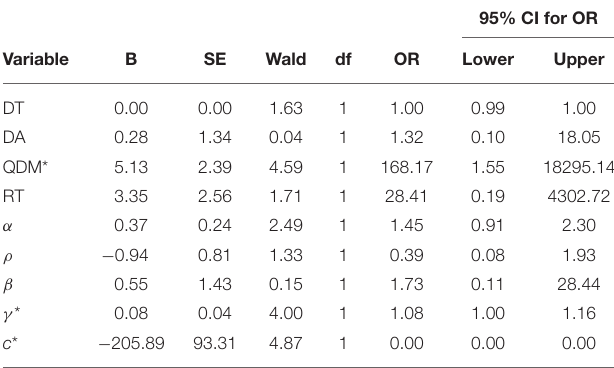
TABLE 4 | Logistic regression predicting treatment outcome (unplanned vs.